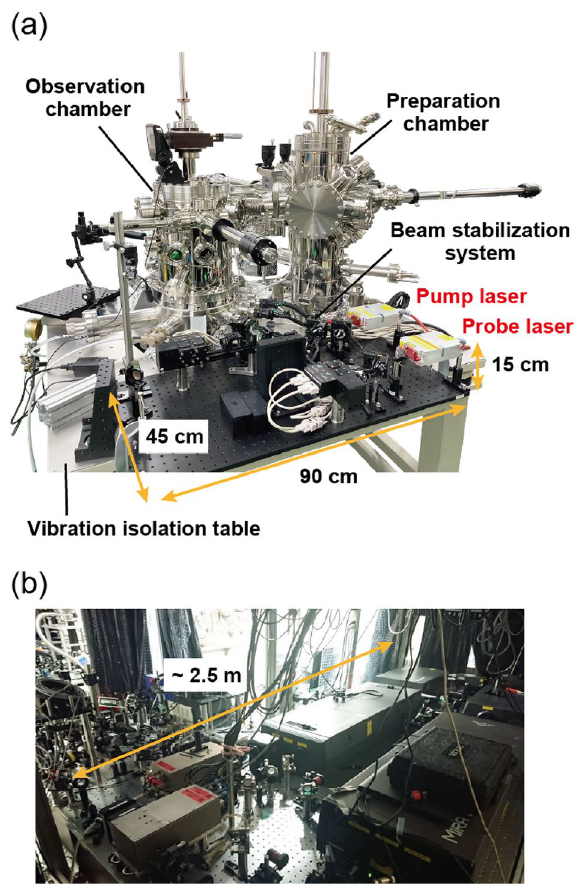
Figure 2. ( a ) Photograph of the STM and the optical system developed in this study. ( b ) Photograph of the conventional optical system used in Ref. 18 .